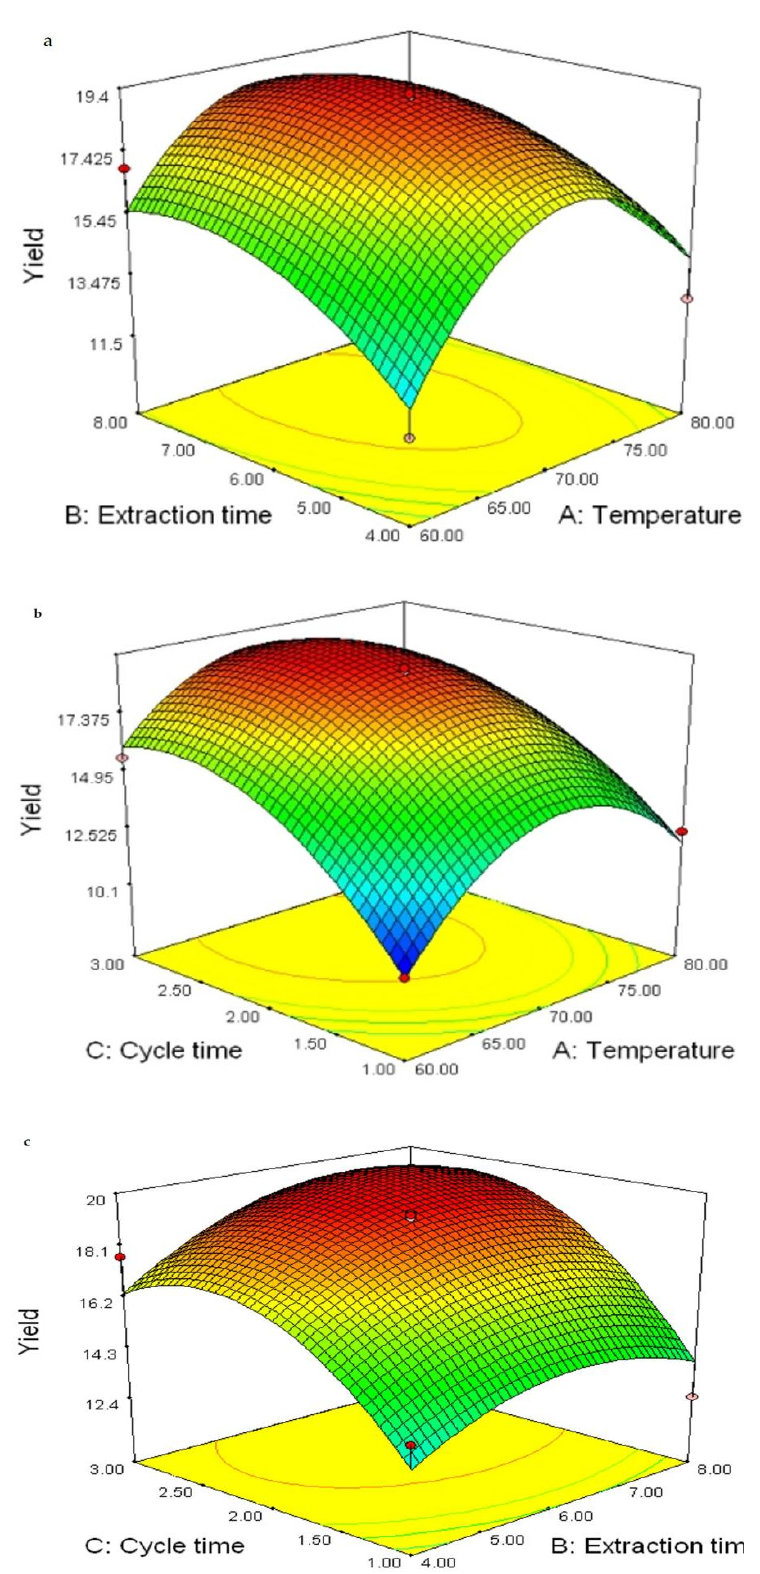
Figure 2. Response surface plots showing the interaction effects of extraction time and extraction temperature ( a ), number of cycles and extraction temperature ( b ), and number of cycles and extrac ‐ tion time ( c ) on the yield of crude polysaccharide.